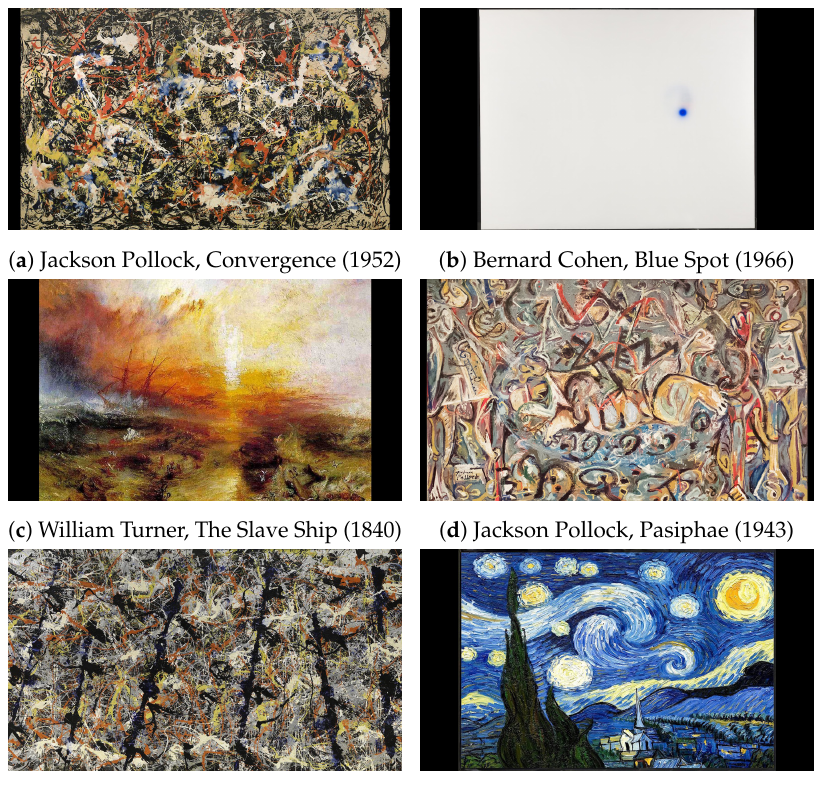
Figure 1. Artworks possessing various levels of abstraction and extremes in geometric complexity— e.g., Pollock’s paintings, being complex, and Cohen’s, being comparatively